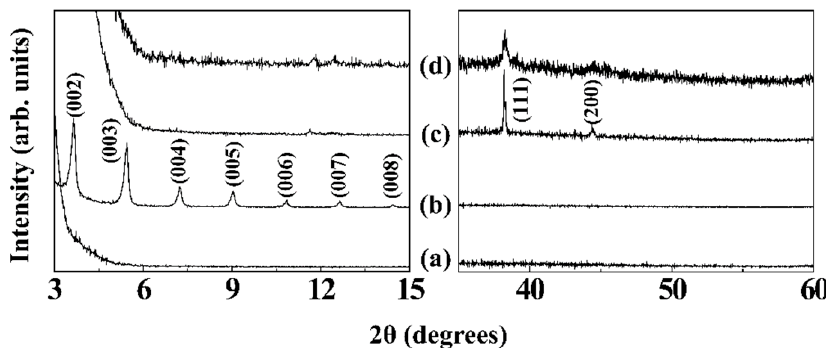
Figure 2. X-ray diffraction patterns of ( a ) bare Si wafer, ( b ) AgSC18@Si, ( c ) Ag-hc@Si, and ( d ) AgNP@Si. 2 θ range between 15° and 35°, where intense silicon single crystal peaks from substrate wafer were shown, was intentionally omitted.